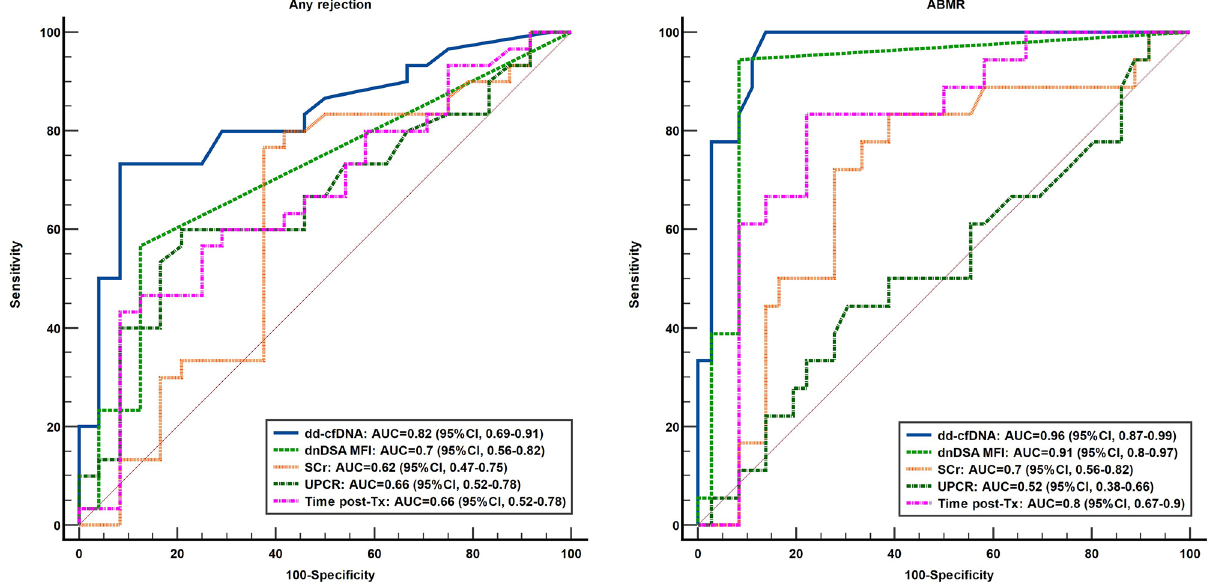
Figure 3. dd-cfDNA discriminates any rejection and ABMR with better performance characteristics compared to other measures of graft function ( dn DSA, donor-specific antibodies, UPCR, urine protein:creatinine ratio; SCr, serum creatinine; Tx, transplant; AUC, area under the